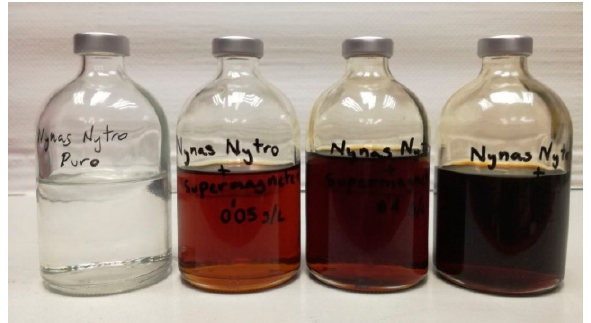
Figure 4. Samples of MO-based DNF with different concentrations of NP. From left to right: MO without NP, MO + FF2 (0.05 g/L), MO + FF2 (0.1 g/L) and MO + FF2 (0.2 g/L).